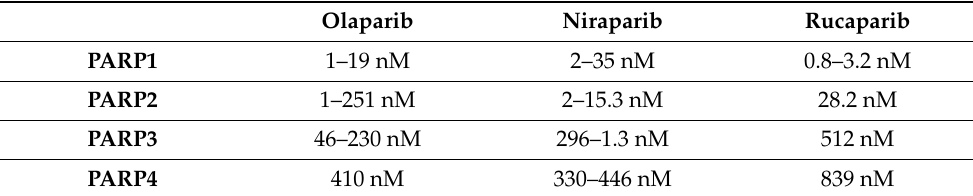
Table 1. PARPi IC50 values for PARP family members. IC50 values have been obtained from the ChEMBL